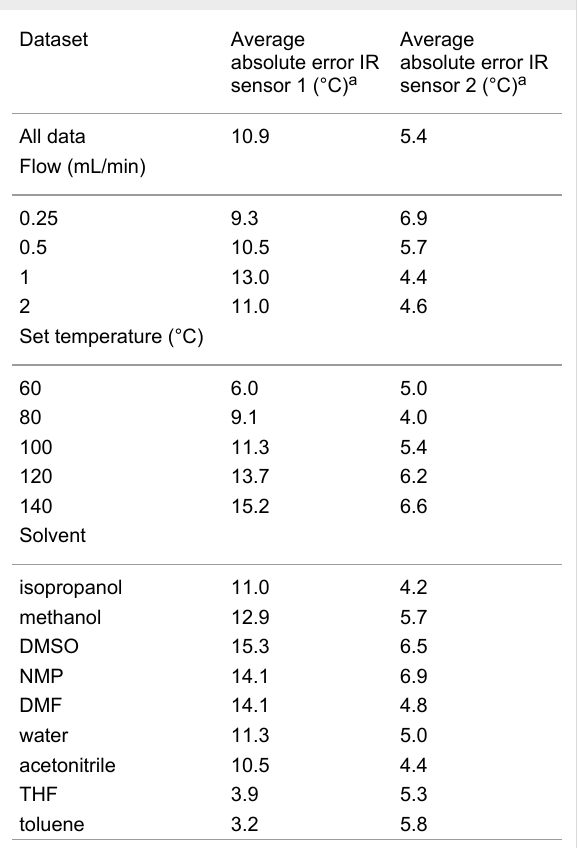
Table 1: Average absolute errors in measurements for the two IR sensors for all data and broken down by flow, set temperature and